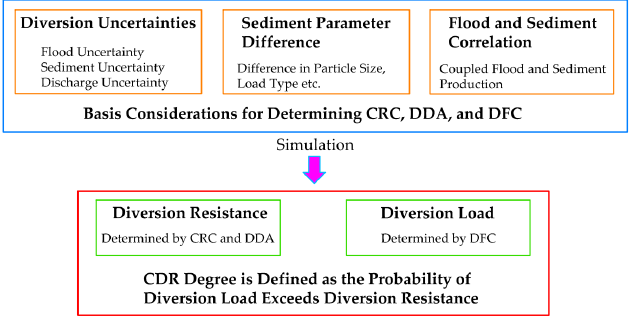
Figure 2. Theoretical framework of Construction Diversion Risk (CDR) assessment on sediment-rich rivers.